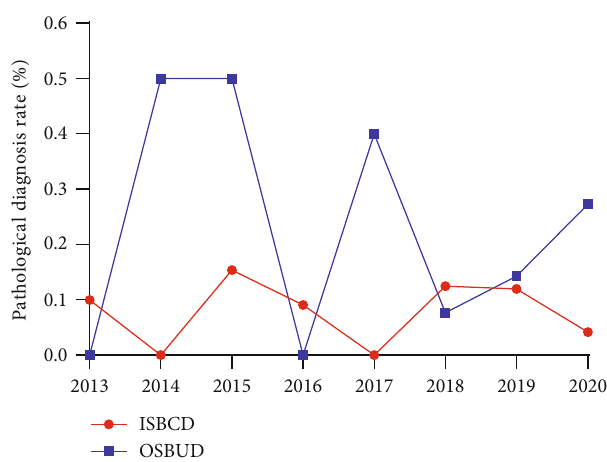
Figure 4: Annual change in the pathological diagnosis